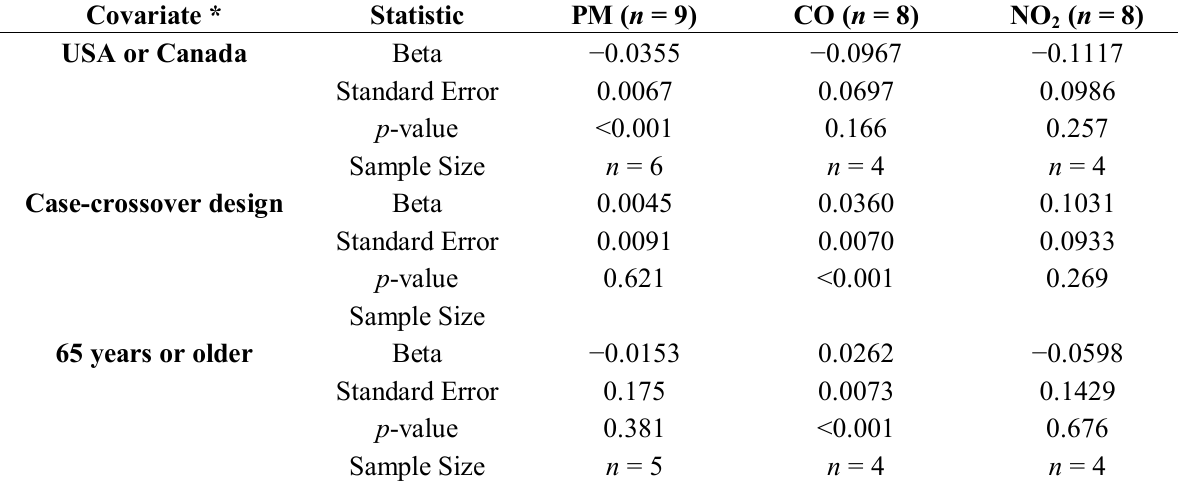
Table 1. Results of the meta-regression models for studies of Congestive Heart Failure (CHF). Beta coefficients indicate the increase or decrease in the log RR that depends on the